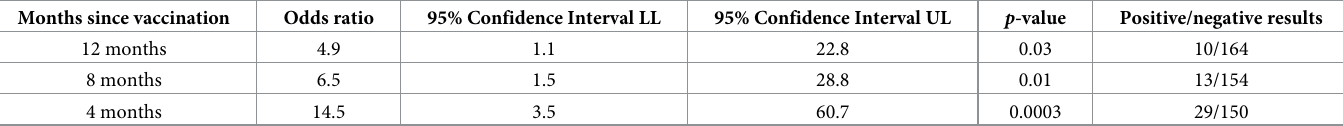
Table 2. Statistical data concerning the level of antibodies to F1 Y . pestis among people have not been vaccinated previously. Months since vaccination